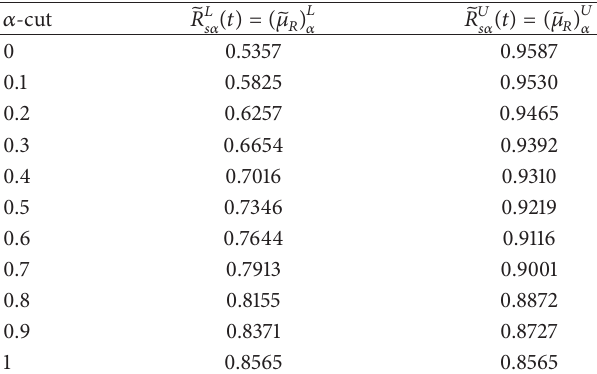
Table 2: The fuzzy parameter of fuzzy system reliability for RMSS in each 𝛼 ∈ [0,1]